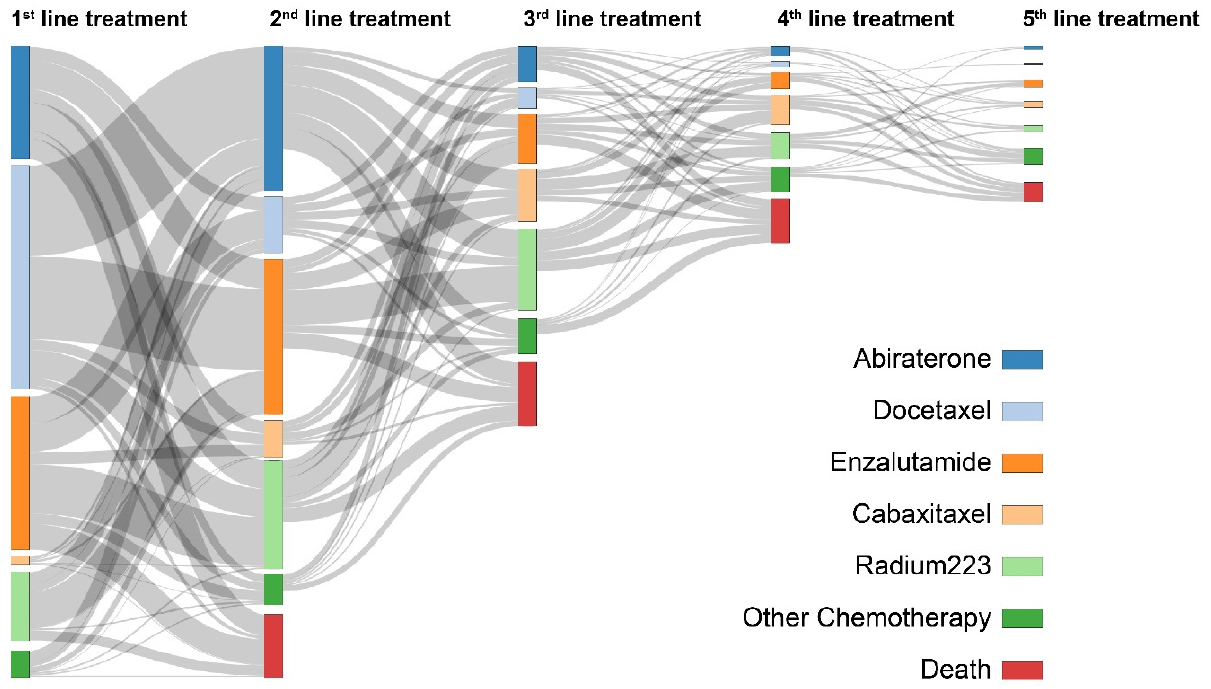
Figure 3. Sankey diagram showing the sequence of systemic therapies among men who developed castrate-resistant prostate cancer (CRPC) by October 2019 ( n = 3400) from their initial presentation of castrate resistance.